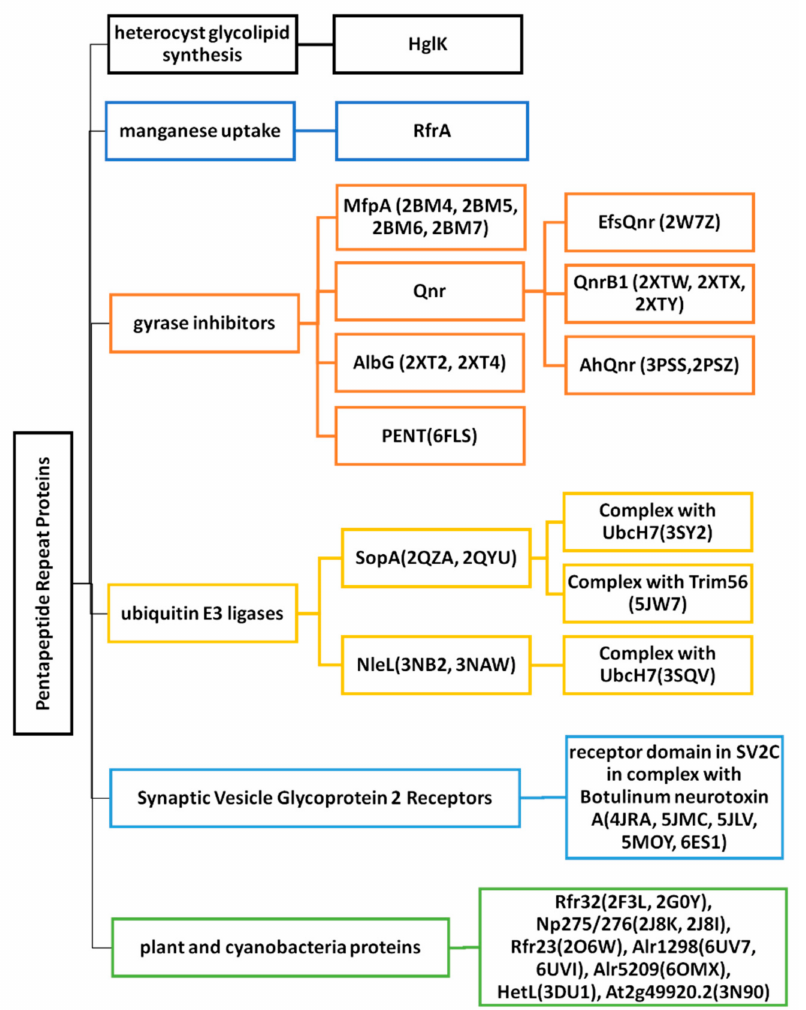
Figure 3. Summary of the PRPs discussed with and without known three-dimensional structures. The six category groups are shown in the first branch. The second and subsequent branches indicate specific PRPs. PRPs with known structures include the corresponding PDB ID inside parentheses immediately to the right of the PRP